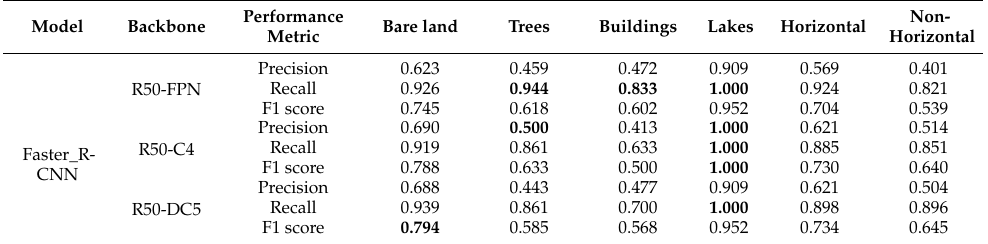
Table 6. Oil well detection performance in different backgrounds and orientations (precision, recall, and F1 score (IoU = 0.5)) (The bold font indicates the best performance for each performance